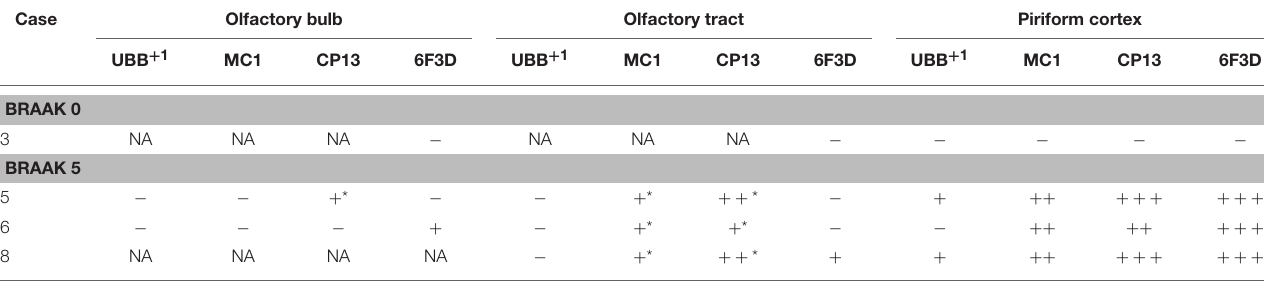
TABLE 3 | Immunoreactivity for UBB + 1 , pre-tangle material (MC1), tangles (CP13) and plaques (6F3D) in paraffin and cryostat sections of the human olfactory system of controls (Braak stage 0), intermediate phase (Braak stage 3) and AD patients (Braak stage